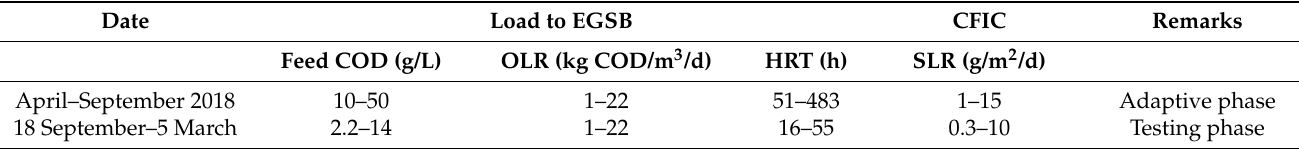
Table 4. Operational